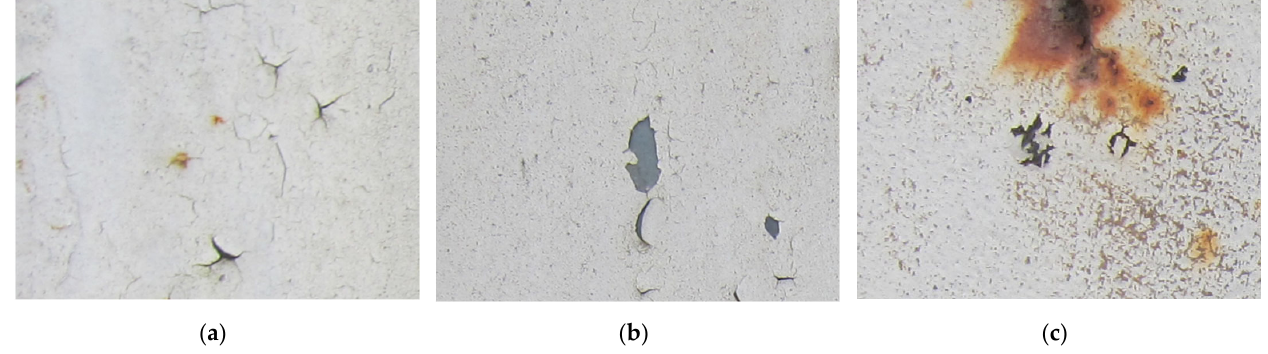
Figure 1. Examples of images of coated surface damages: ( a ) rust and paint cracking; ( b ) paint flaking and cracking; ( c ) rust damage and paint flaking.